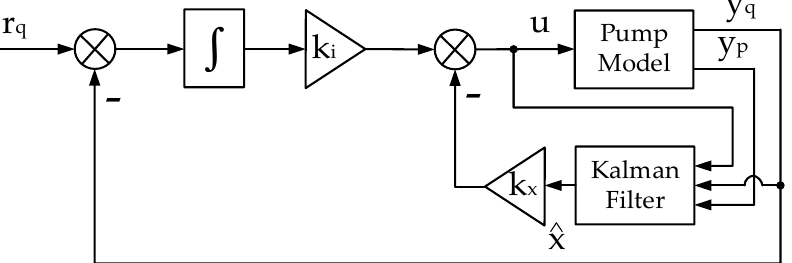
Figure 13. Structure of closed-loop system with LQG controller and Kalman filter.